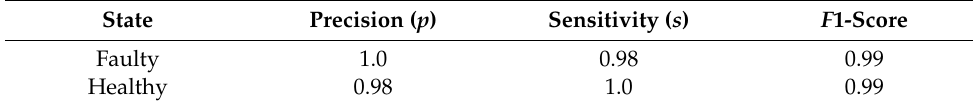
Figure 13. Welding motion-based CM for the proposed TL-based FDD approach. Table 4. Performance metrics for the proposed TL-based FDD for welding motion.